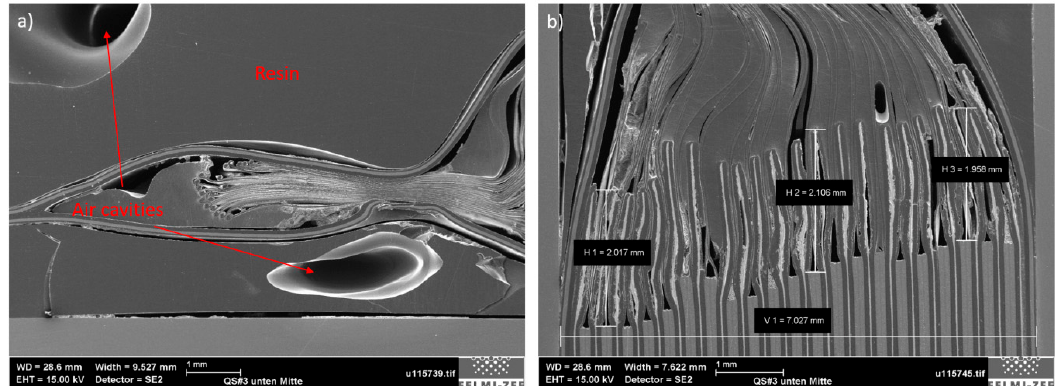
Figure 5. Cross-sectional images of Sample #3 as generated from the battery side, positioned opposite to the cell tabs. ( a ) View of the sample edge where the separator is welded at the pouch sealing point; ( b ) extension of the separator from the edge towards the middle of the battery and the cell layer arrangement.